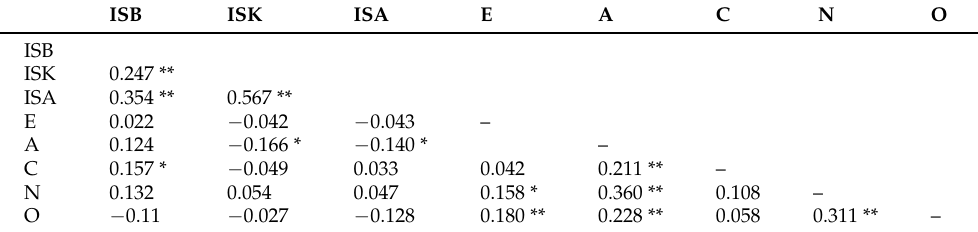
Table 7. Correlations between personality traits, and security practice